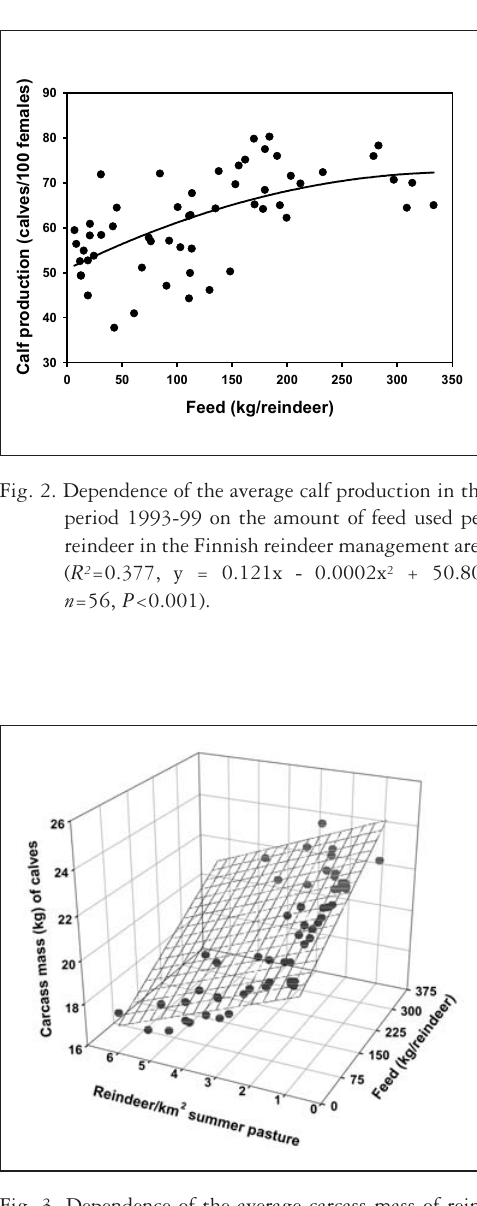
Fig. 3. Dependence of the average carcass mass of rein- deer calves in the period 1993-99 on reindeer density on summer pastures and feeding of rein- deer in the Finnish reindeer management area ( R 2 =0.723, y = -0.595x + 0.013z + 20.715 where y = carcass mass (kg) of calves; x = rein- deer/km 2 summer pasture; z = feed, kg/reindeer, n =56, P clear effect on stock productivity in this same peri-